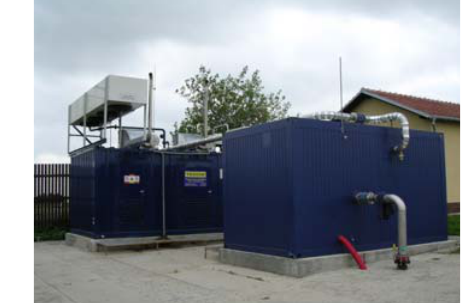
Figure 11 – Petruvky, CZ, TEDOM Cento T 300 SP 300 kWe, 370 kWt Рис . 11 – Petruvky, CZ, TEDOM Cento T 300 SP 300 kWe, 370 kWt Слика 11 – Petruvky, CZ, TEDOM Cento T 300 SP 300 kWe, 370